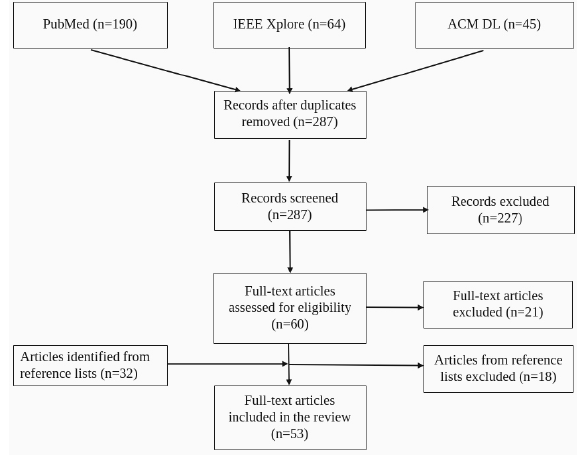
Figure 1. Flow diagram of the review process. Of 287 identified research papers, thirty-nine were included in the review (PubMed n = 31, IEEE Xplore n = 6, ACM Digital Library n = 2). In addition, fourteen papers from the reference lists were included in the